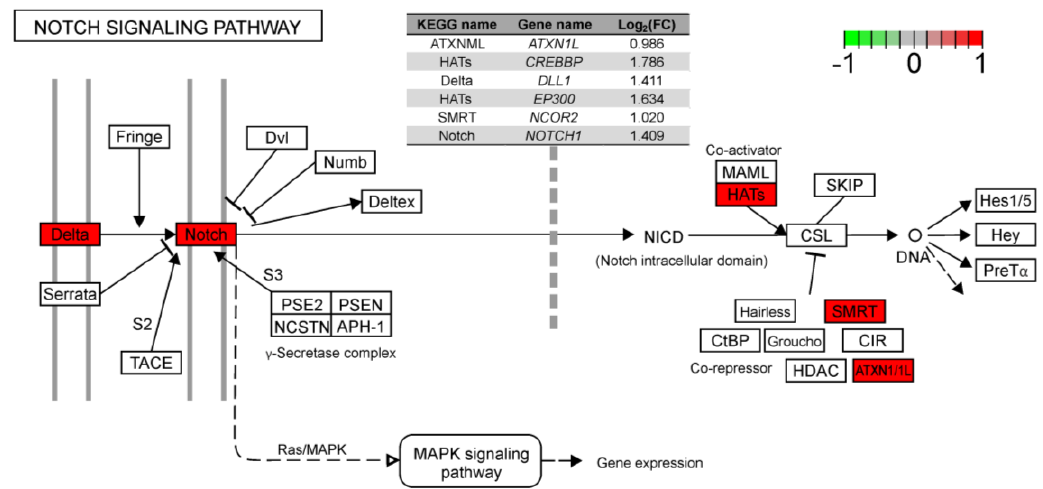
Figure 4. Enrichment Kyoto Encyclopaedia of Genes and Genomes (KEGG) analysis of DEGs engaged in the Notch signaling pathway.